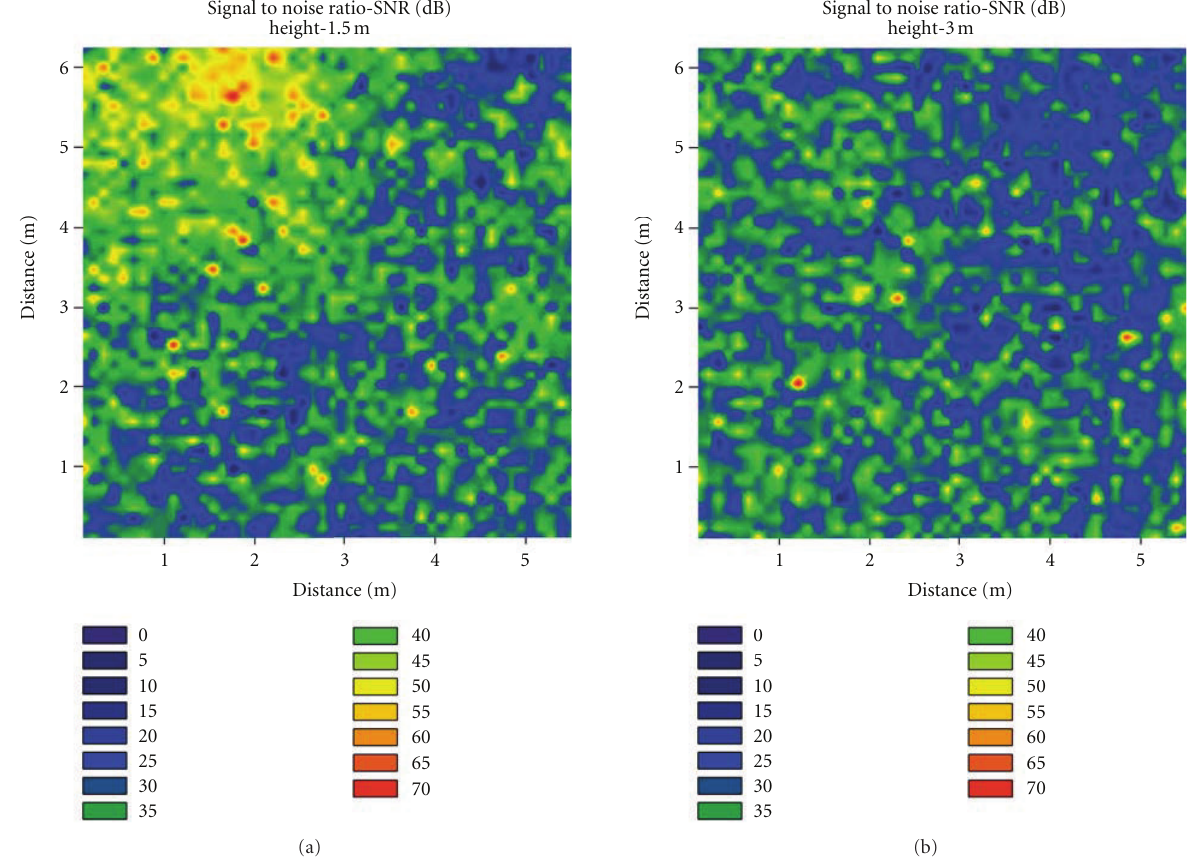
Figure 11: Spatial distribution of signal to noise ratio for di ff erent heights in the indoor scenario of Figure 2(a) with the 3D ray launching